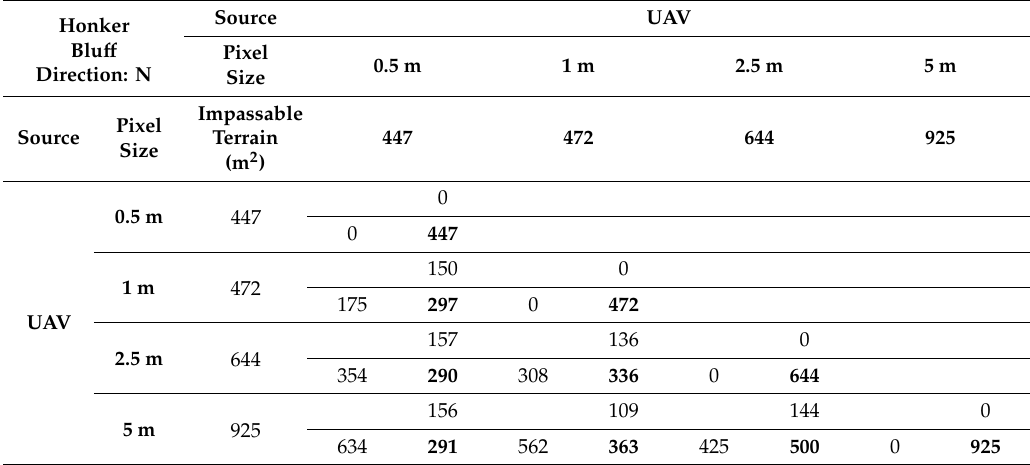
Table 8. Intersection between impassable areas of the Honker moving northward in blu ff terrain (UAV data).